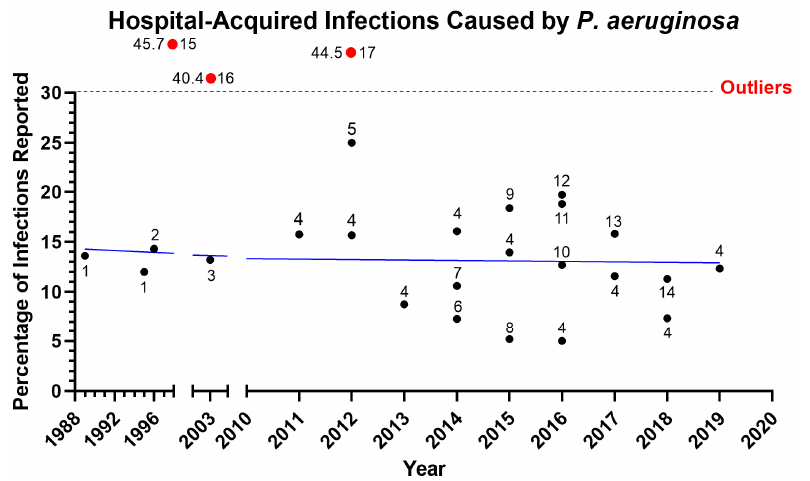
Figure 1. Infection rates of P. aeruginosa in hospitalized patients over the past 3 decades (1989–2019). Hospital-acquired infections reported included bloodstream infections and catheter-associated bloodstream infections, catheter-associated urinary tract infection, surgical site infections and burn wound infections, and hospital-associated and ventilator-associated pneumonia; although not every article reported every category, all except two included three or more categories. The blue line is a regression line for the data excluding outliers, which are shown above the dotted red line. The numbers associated with the black circles indicate reference numbers; the numbers to the left of the red circles are the percentages, and those to the left are the reference numbers. References: 1. [5], 2. [6], 3. [7], 4. [8], 5. [9], 6. [10], 7. [11], 8. [12], 9. [13], 10. [14], 11. [15], 12. [16], 13. [17], 14. [18]. Outliers: 15. [19], 16. [20], 17. [21].